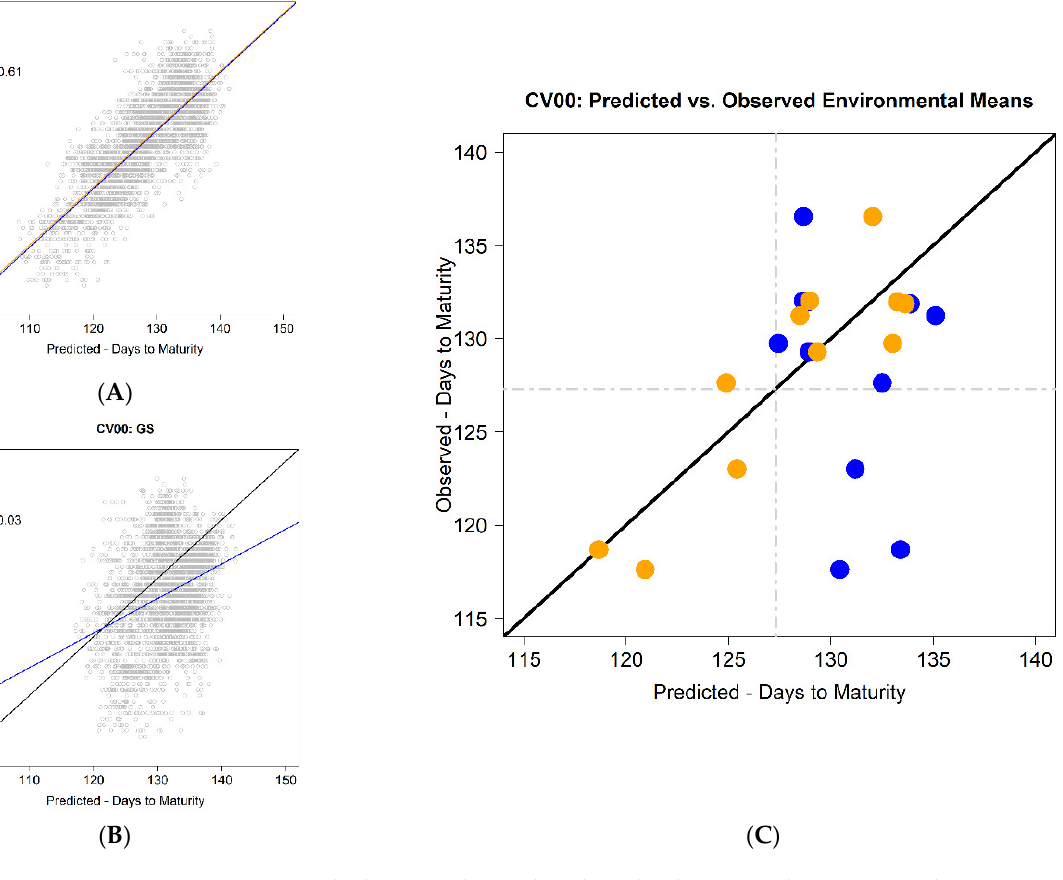
Figure 6. Scatterplot between the predicted (under the CV00 scheme, untested genotypes in unob- served environments) and observed DTMs of 367 soybean genotypes across 11 environments for the CB-method ( A ) and the conventional GP model ( B ) and their corresponding environmental means ( C ). The blue line indicates the fitted line between the predicted and observed DTM values, the black line denotes the 1:1 line that represents the null hypothesis of no difference between the observed and predicted observations, and the environmental means are indicated with orange and blue symbols that denote paired O and P points of the CB-method and the conventional GP model,